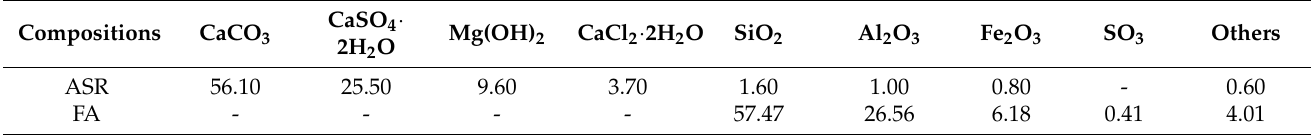
Figure 1. X-ray diffraction curves of solid wastes: ( a ) FA and ( b ) ASR. Table 1. Chemical compositions of ASR and FA (wt.%). Table 1. Chemical compositions of ASR and FA (wt. %).